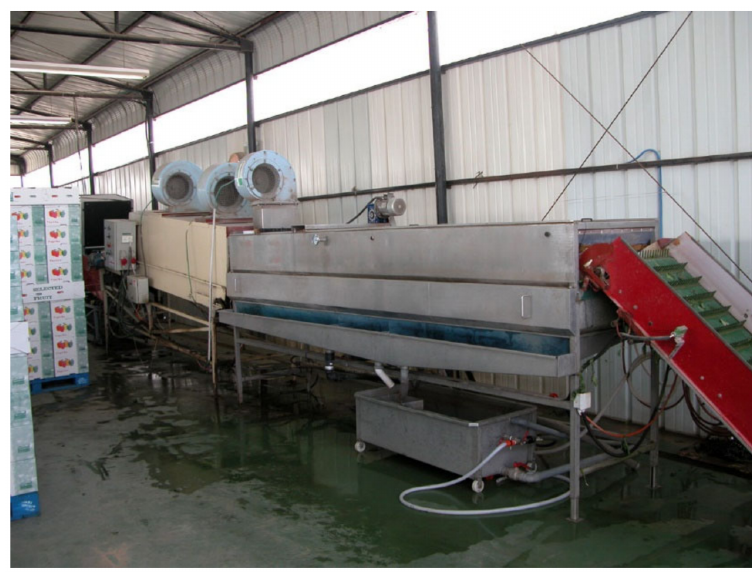
Figure 3. Fourth version, 2000 (photo by E.